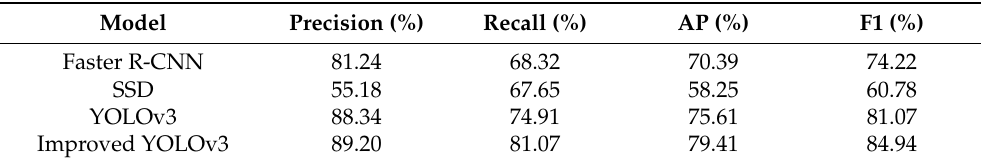
Table 6. Comparison of test results of four models on headless stud